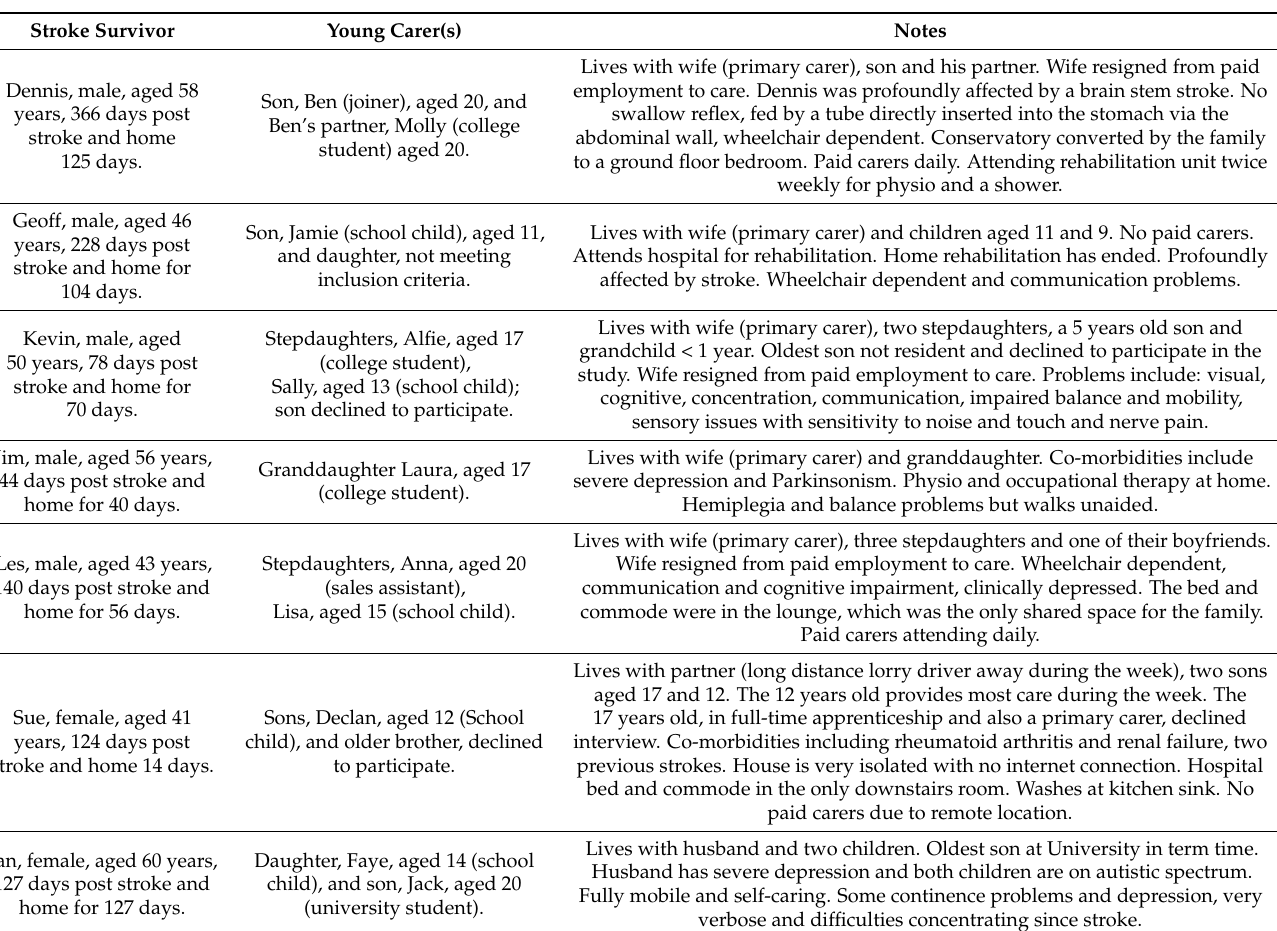
Table 3. Vignettes of stroke survivor participants and their young